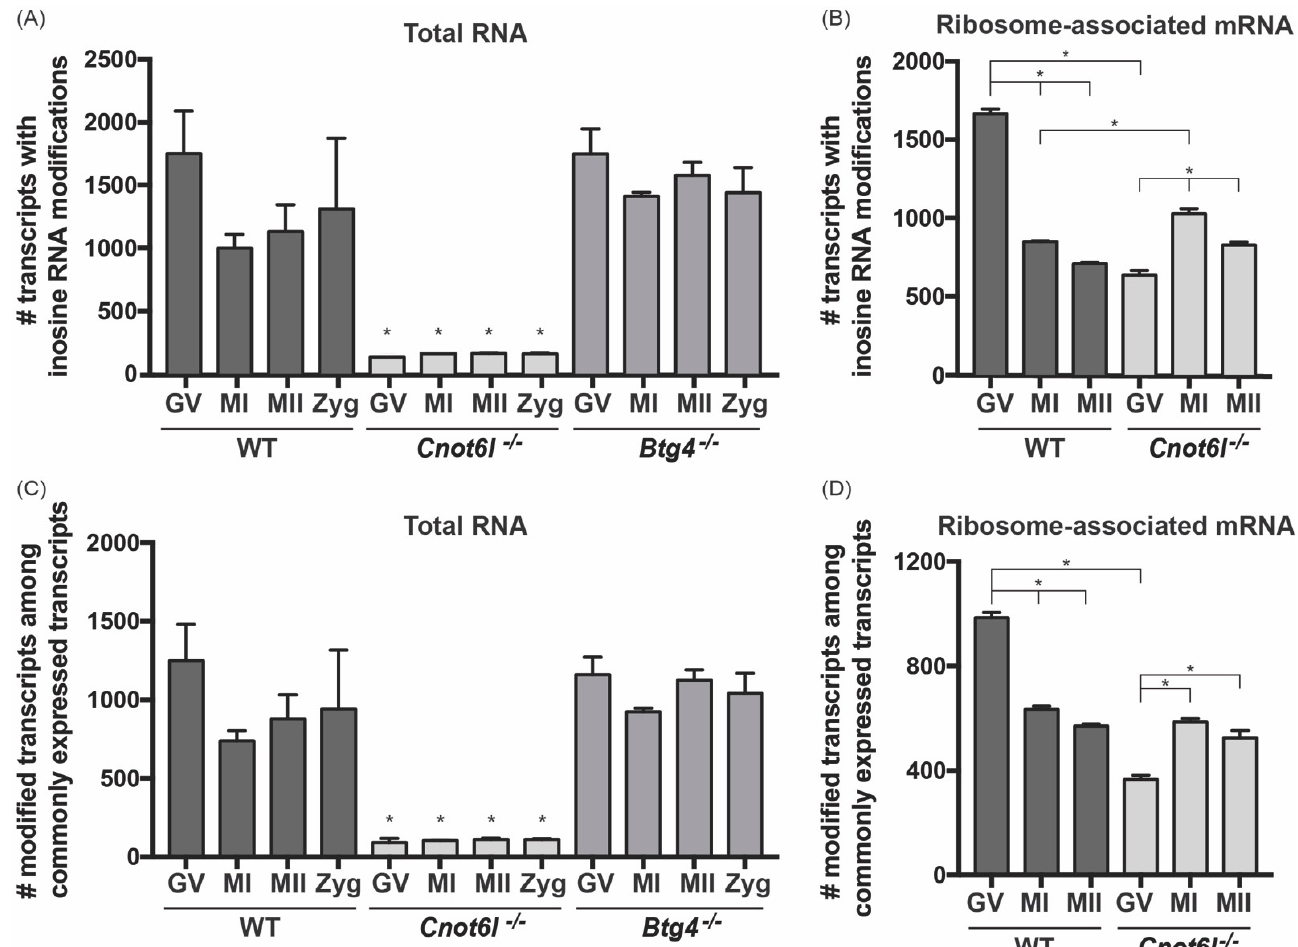
Figure 1. Inosine RNA modifications occur in transcripts enriched in the ribosome-associated RNA. ( A , B ) The number of unique inosine modified transcripts identified in wild-type (WT), CCR4-NOT Transcription Complex Subunit 6 Like ( Cnot6l ) -/- , and B-cell translocation gene-4 ( Btg4 ) -/- GV, MI, MII, and Zyg in total RNA ( A ) and ribosome-associated mRNA ( B ). ( C , D ) Among common transcripts present in all samples, the number of unique inosine modified transcripts identified in WT, Cnot6l -/- , and Btg4 -/- GV, MI, MII, and Zyg in total RNA ( C ) and ribosome-associated mRNA ( D ). *Means ± SEM within panels A and B are different ( p < 0.05).